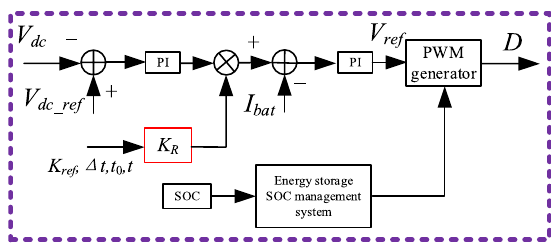
Fig. 6 Energy storage control strategy diagram under K R factor